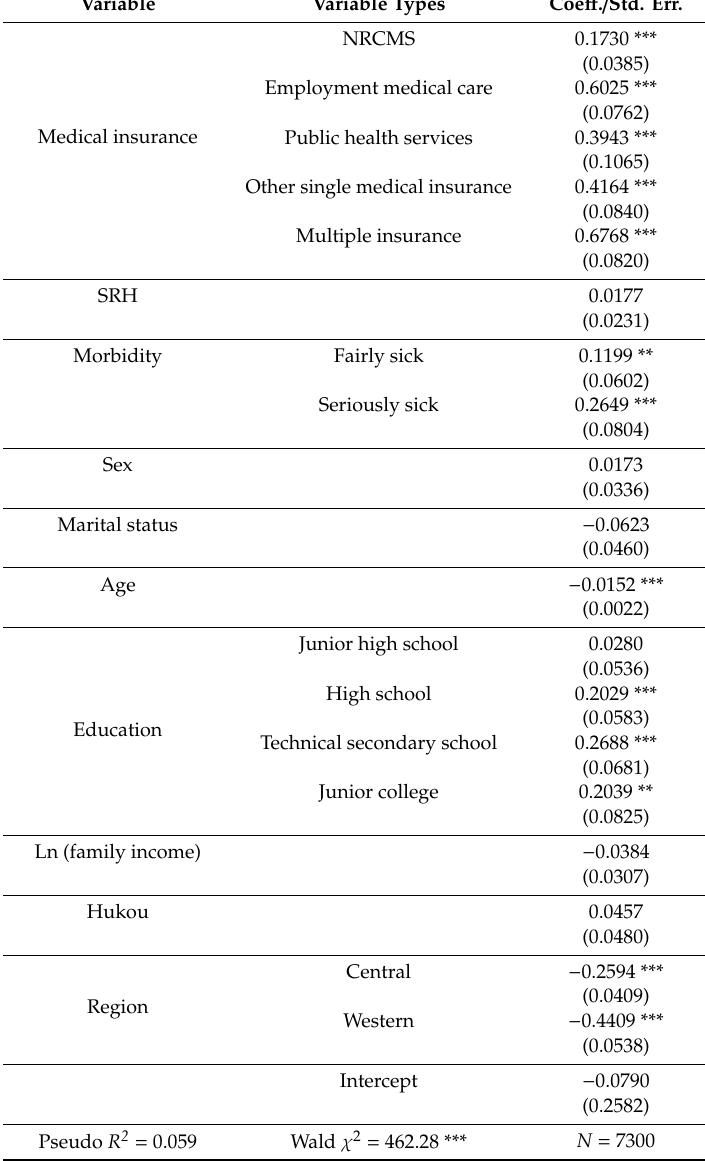
Table 5. Probit regression results for migrant workers’ preventive medical service